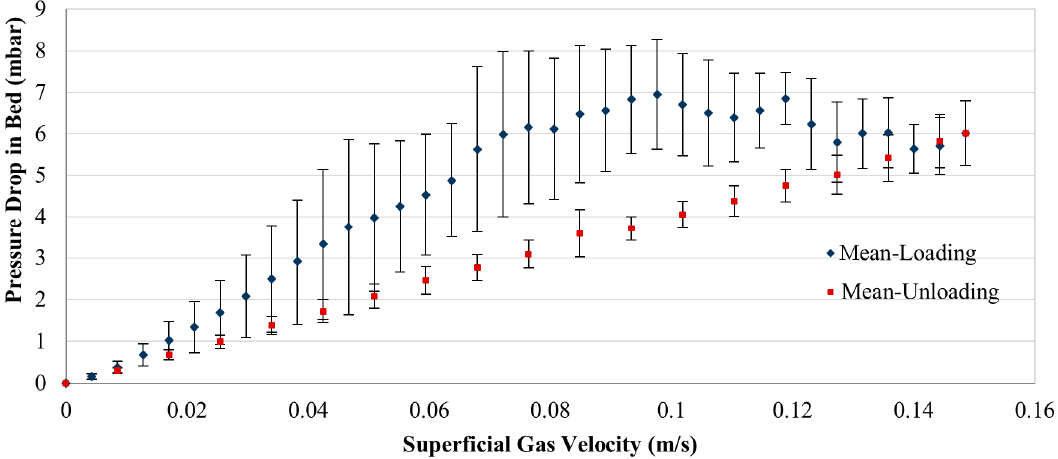
Figure 13. Mean value (symbols) and standard deviation (vertical bars) of ∆ P b ( U sg ) when repeating fluidization tests for fluidization loading and unloading of ultra-fine powder bed (CALCIT MX-10).